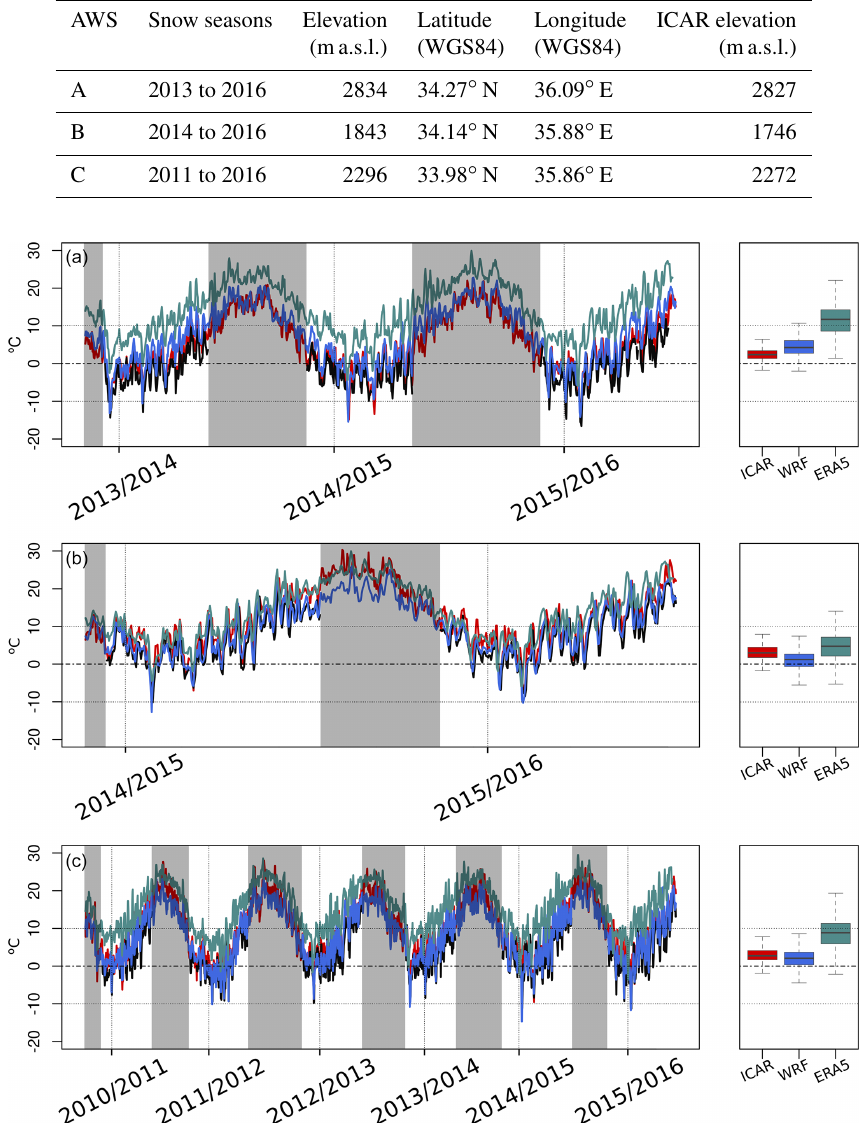
Figure 3. ERA5 (green), WRF (blue), ICAR (red) and AWS (black) daily temperature data. The box plots represent the distribution of the errors, and the gray shadows represent the data gaps in the